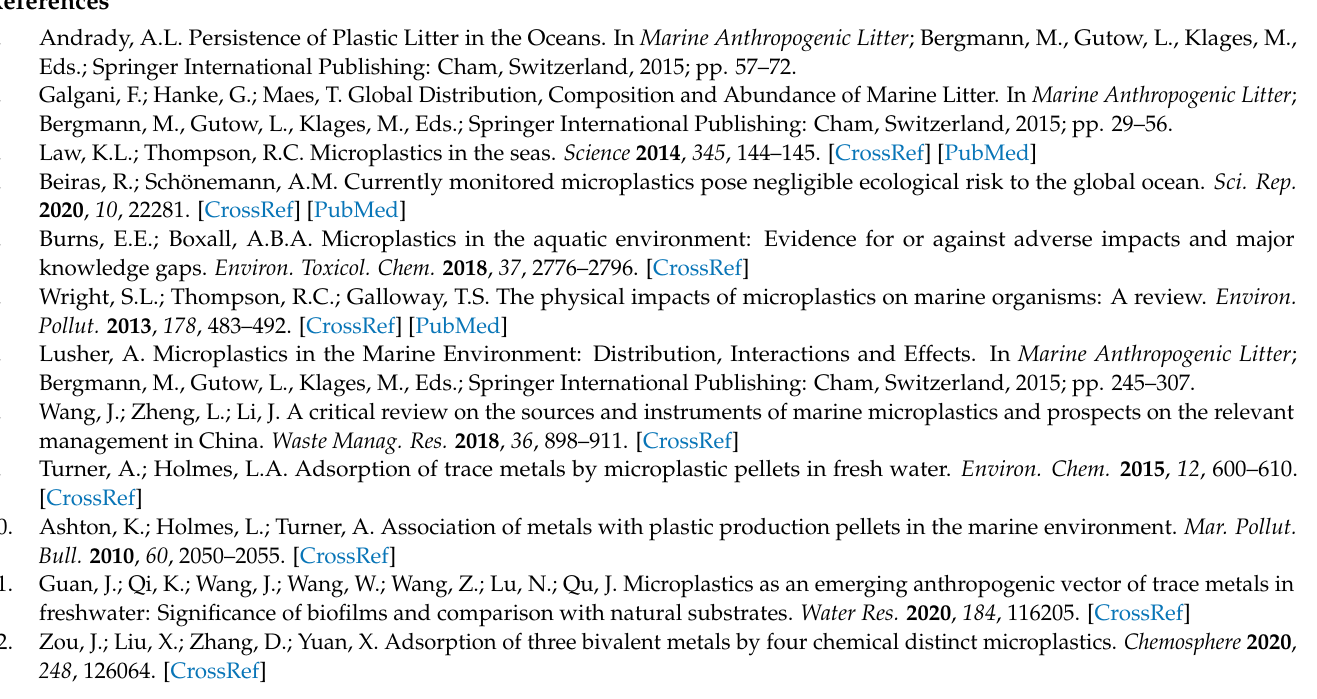
Table S2: Hydrophobicity of the plastic debris used in the experiments;. Table S3. Atomic percentages (%) for the elements on the plastic debris surfaces before metals